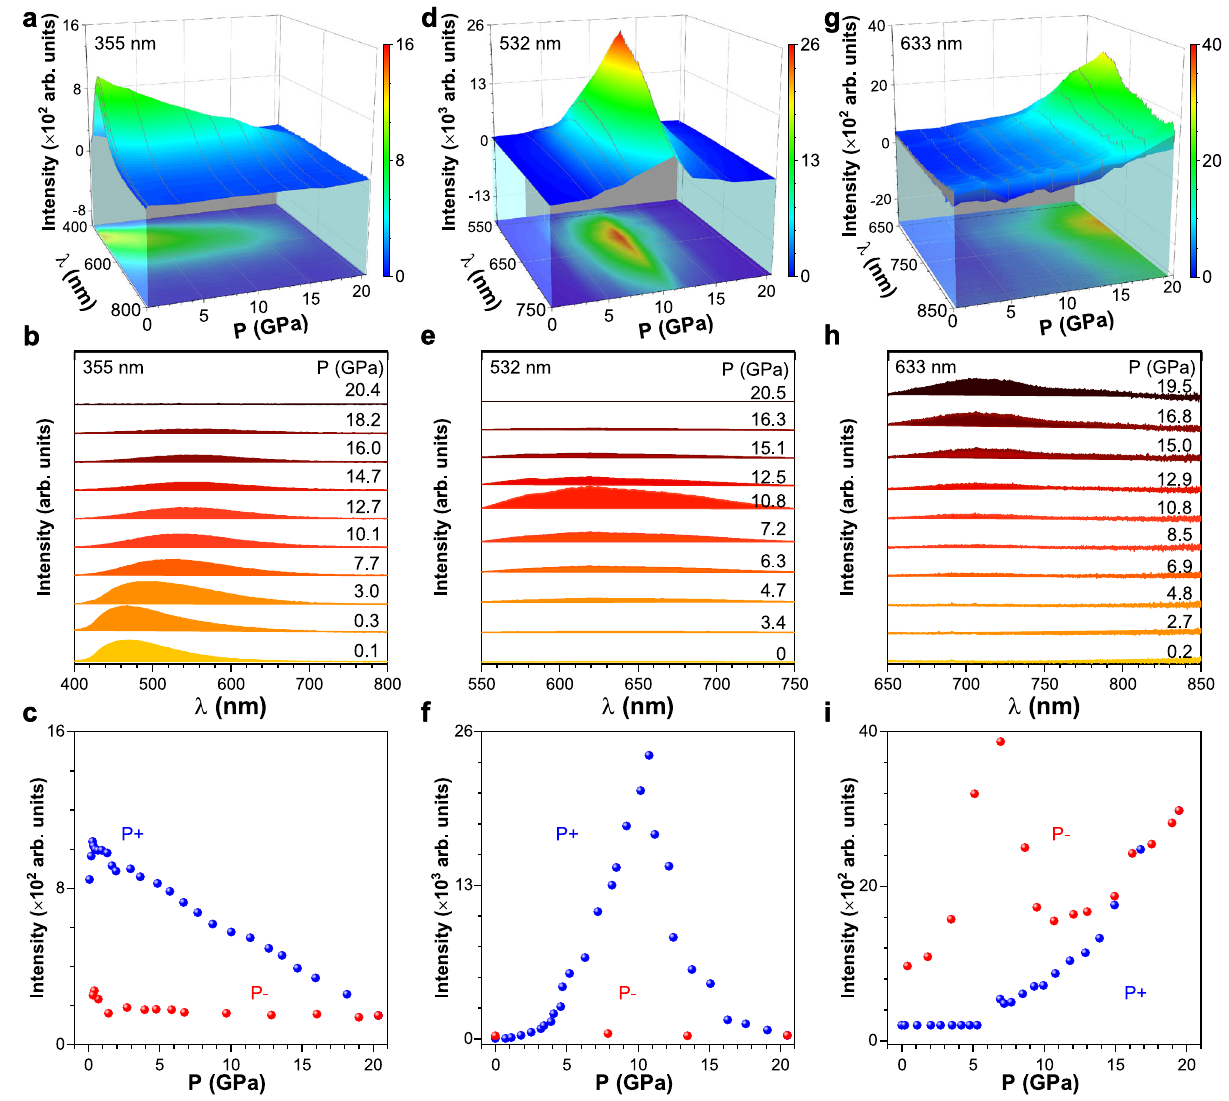
Fig. 3 | Fluorescence monitoring of FTPE crystal structural evolution under high pressure. Pressure-dependent 3D and 2D fl uorescence spectraofFTPEsingle crystal during the compression process under laser excitation at ( a , b ) 355nm, ( d , e ) 532nm, and ( g , h ) 633nm. Changes in the fl uorescence intensity with